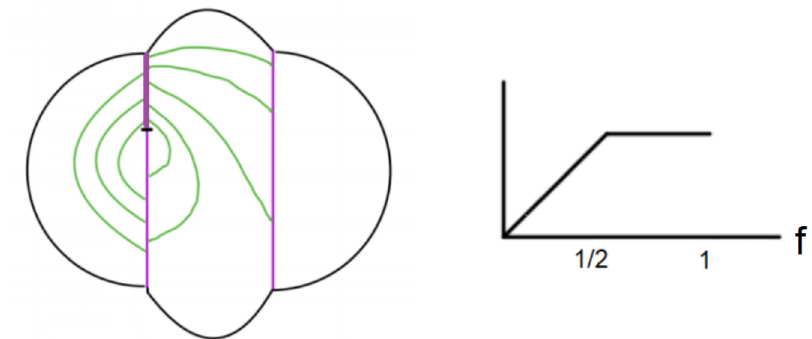
Figure 15 . Bit-thread diagram for a split horizon in the bilayer theory. The right panel shows the entanglement entropy as a function of f